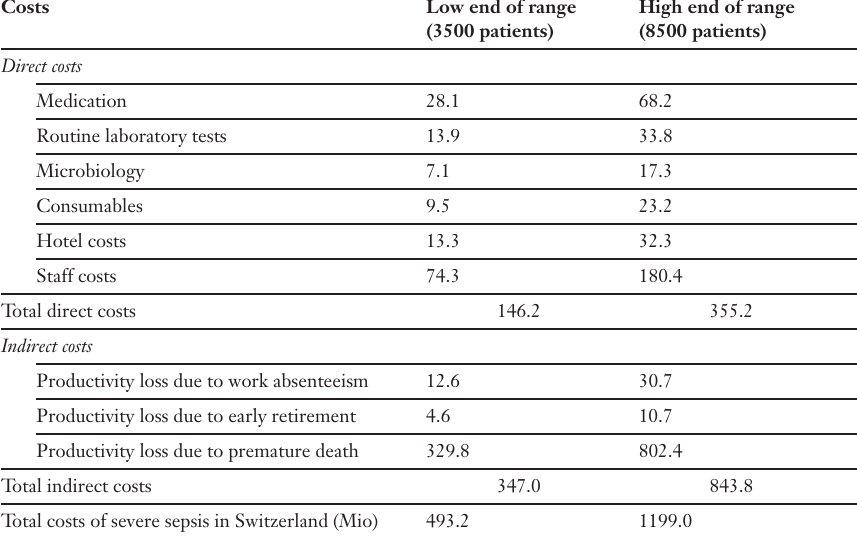
Total costs of severe sepsis in Switzerland per year (Mio